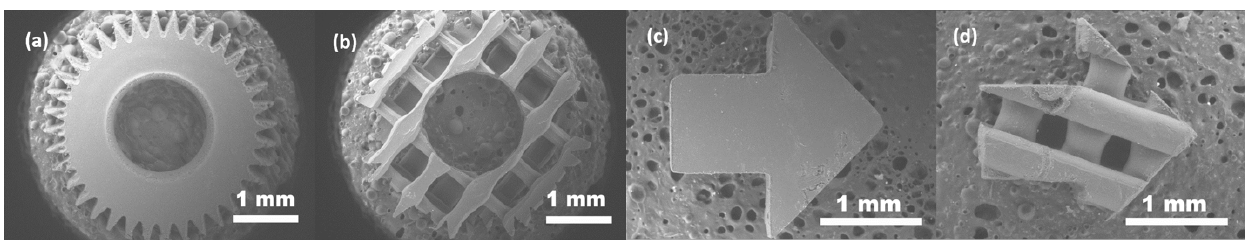
Figure 8. SEM micrographs of FPF cut shapes: ( a , c ) bulk; ( b , d ) woodpile-scaffold